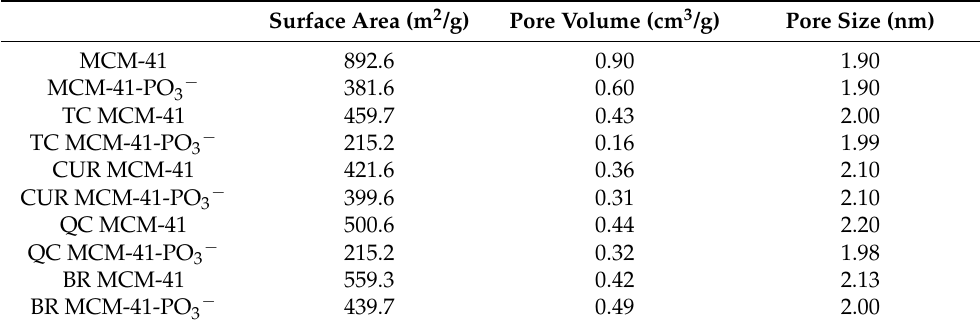
Table 2. Surface area (m 2 /g), pore volume (cm 3 /g), and pore size (nm) for SrtAI-loaded and non- loaded MCM-41 and MCM-41-PO 3 − MSNs.